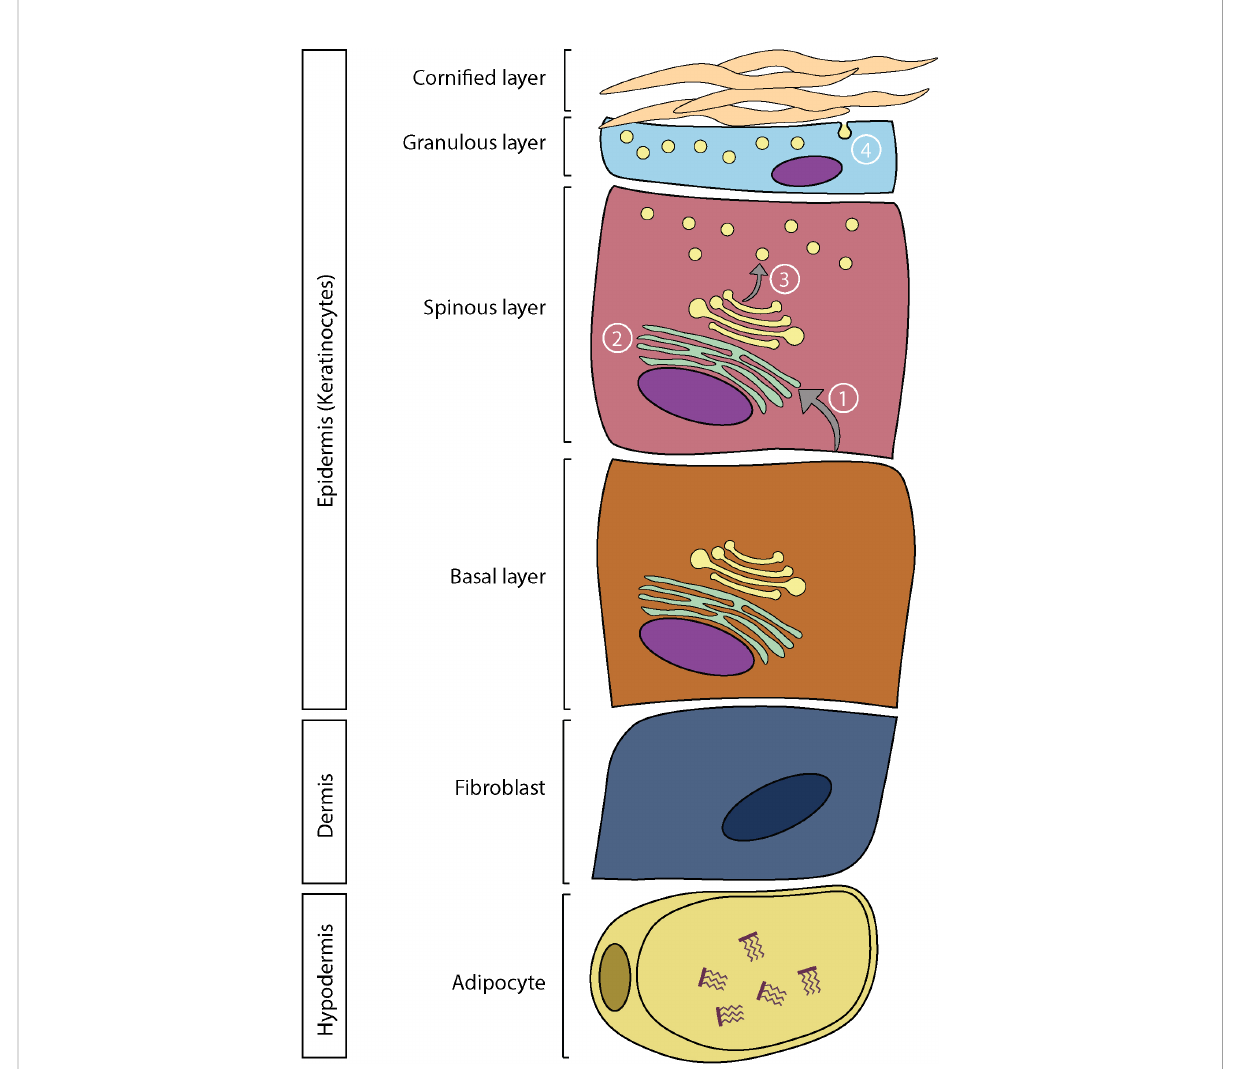
FIGURE 1 Skin structure and lipid metabolism. In the epidermis: 1) Fatty acids are hydrolyzed from phospholipids and transported in the endoplasmic reticulum. 2) Synthesis of more complex lipids. 3) Storage of lipids in lamellar bodies. 4) Extrusion of lamellar bodies and organization of the lipid